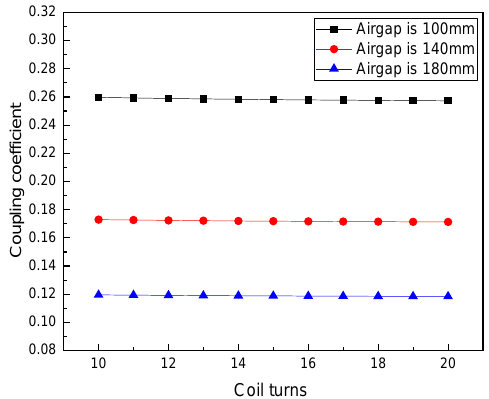
Figure 12. Coupling coefficient versus the number of turns.